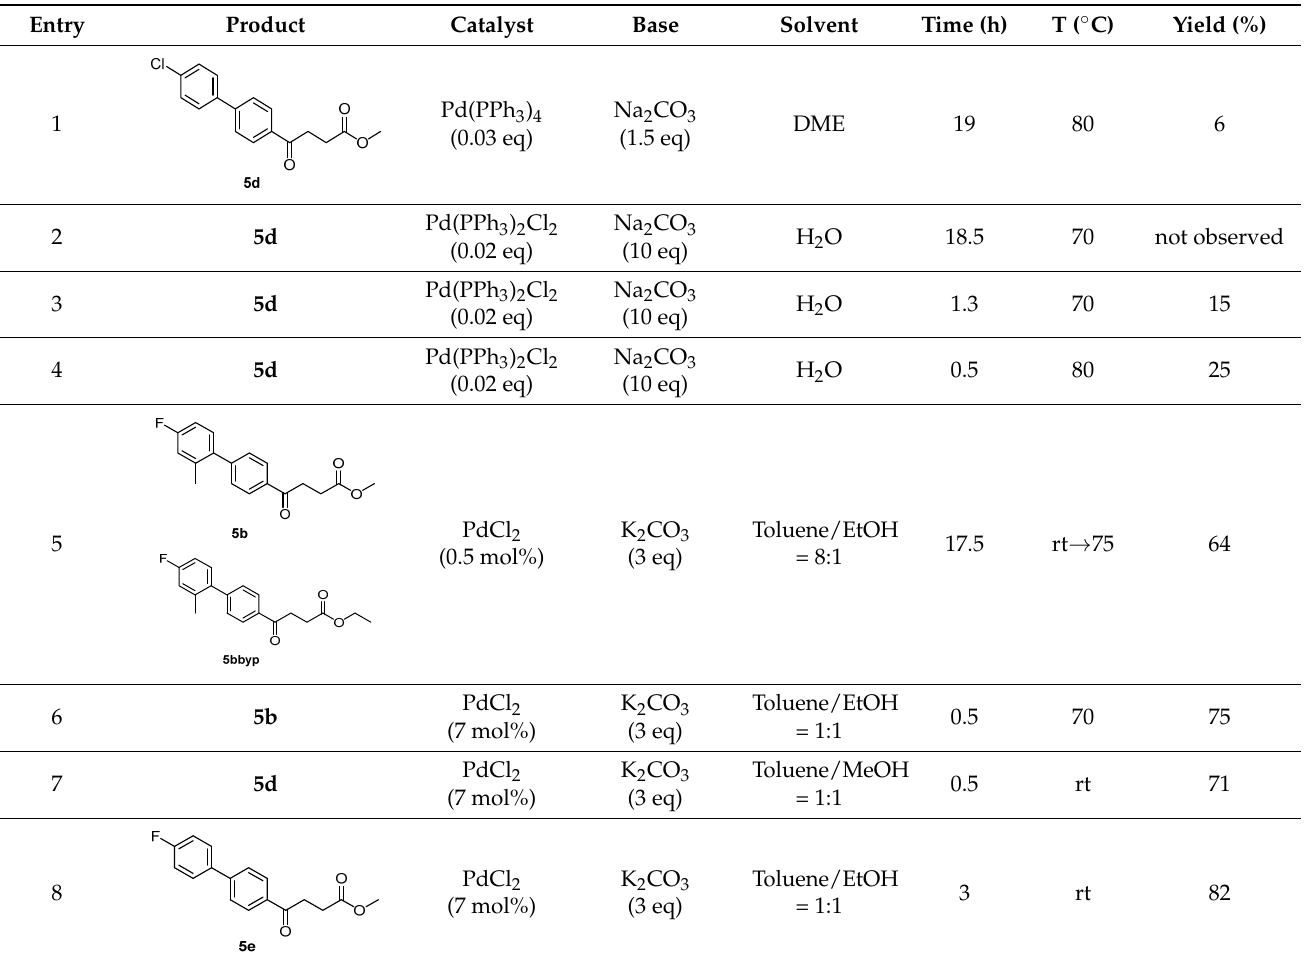
Table 1. Optimization for S-M coupling condition.